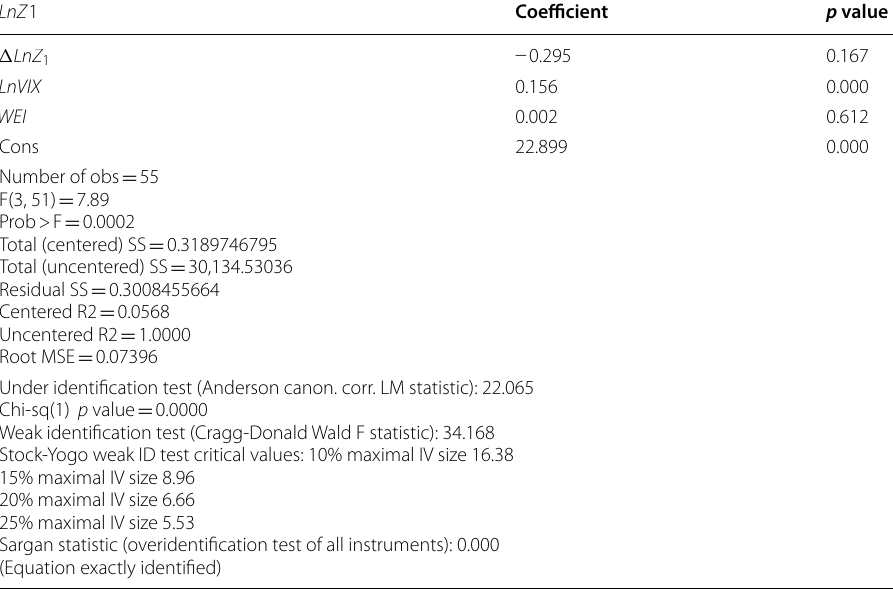
Table 6 Results of Bewley transformation from instrument variable